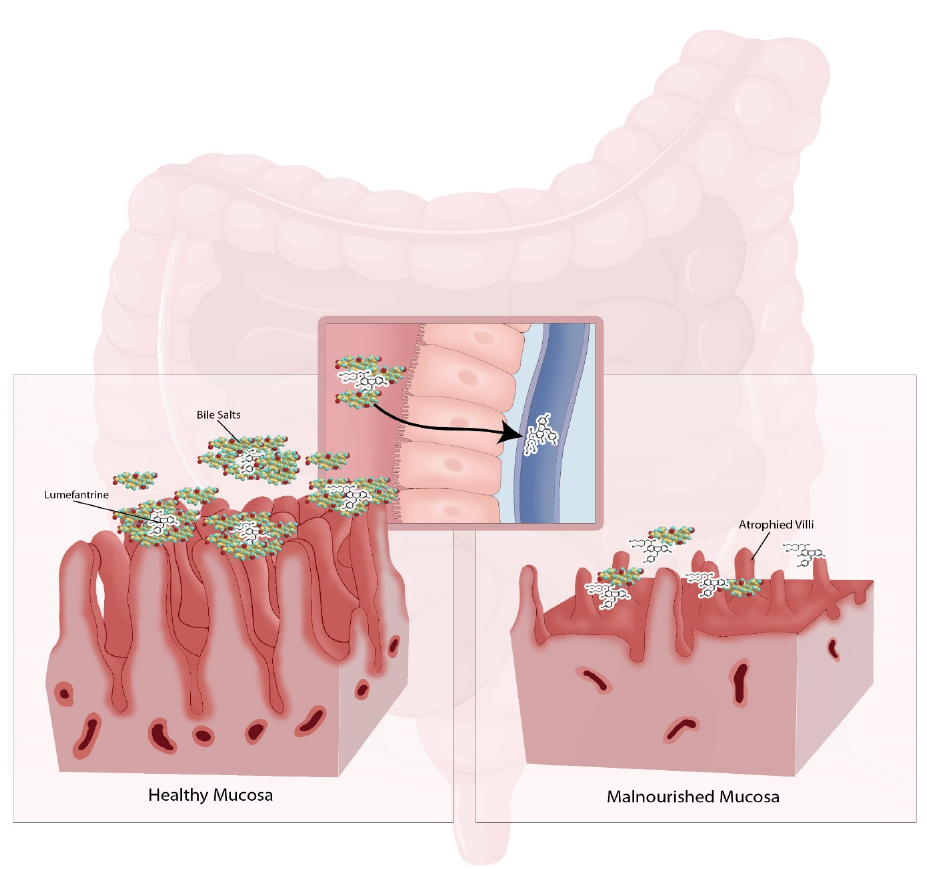
Figure 1. The intestinal mucosae in healthy and malnourished subjects, showing the atrophy of villi in the jejunum as well as the reduced amount of bile, which is required to augment the absorption of compounds such as lumefantrine.